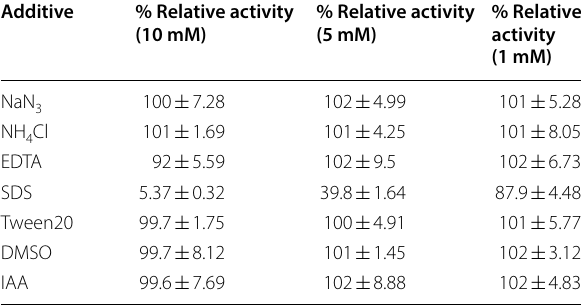
Table 3 Effect of the presence of additives on AMG